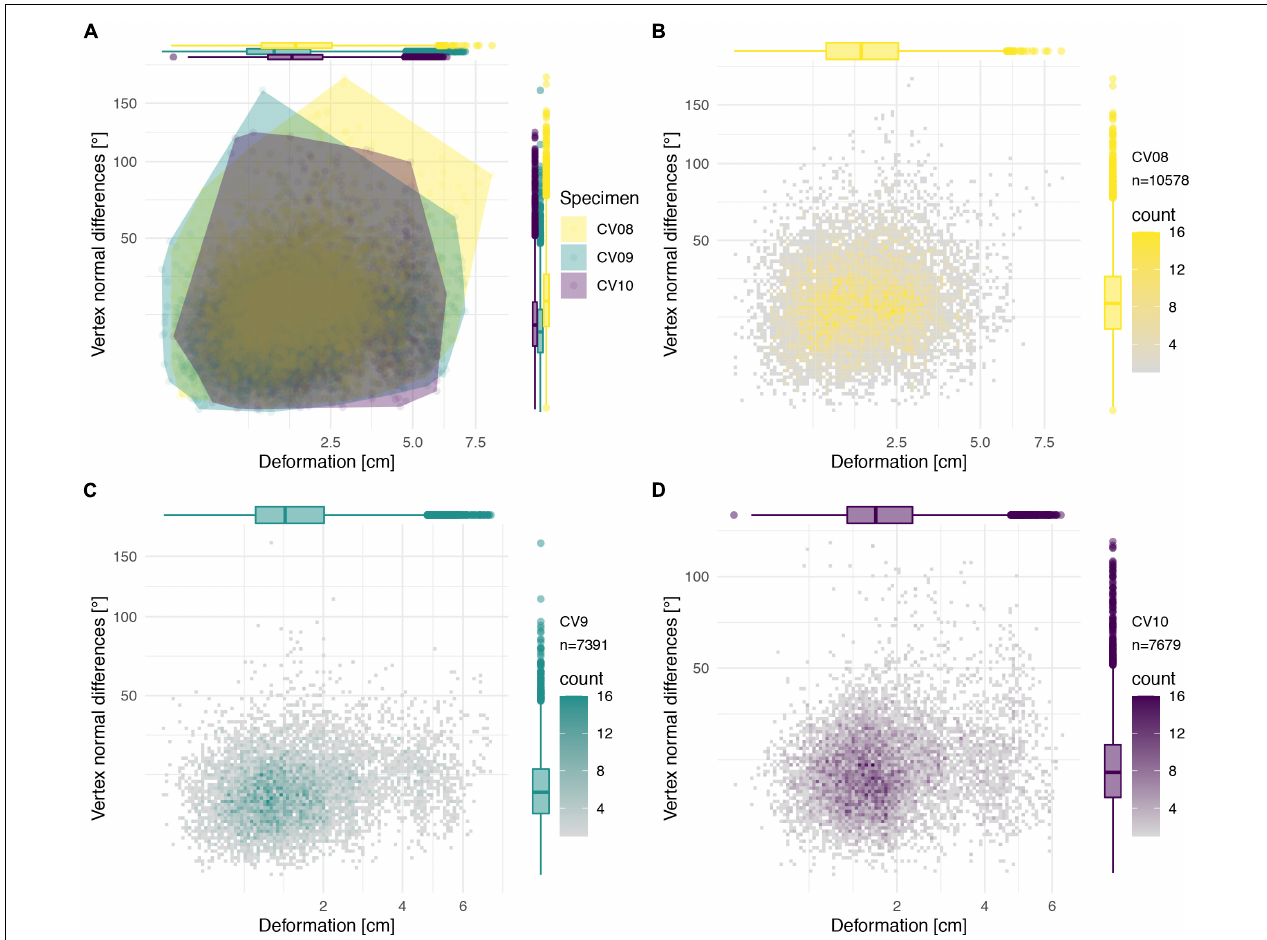
FIGURE 10 | Deformation comparison of the different vertebrae. Scatter plot of absolute global deformation ( X -axis) and local deformation ( Y -axis) of all vertebrae (A) , combined arch and centrum of CV 8 (B) , CV 9 (C) , and CV 10 (D) . Note the different number of landmarks “ n ” for each specimen.